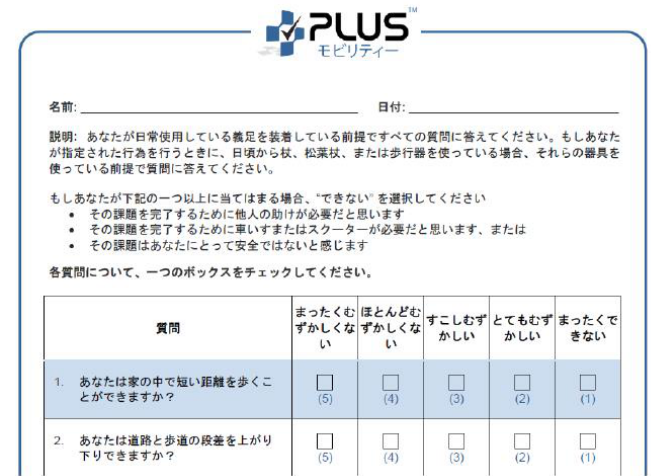
Figure 1 . Japanese translation of PLUS-M short